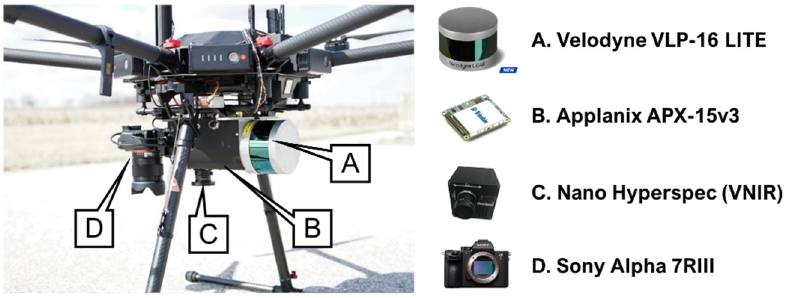
Figure 4. The unmanned aerial vehicle (UAV) mobile mapping system and onboard sensors used in this study.